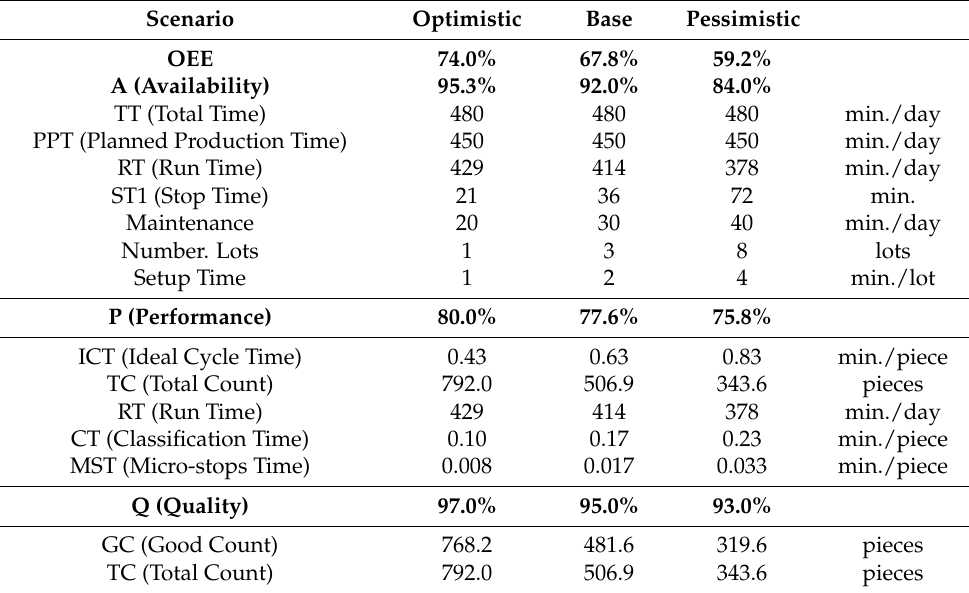
Table 1. Initial scenarios for calculation of current OEE in the edge banding machine.